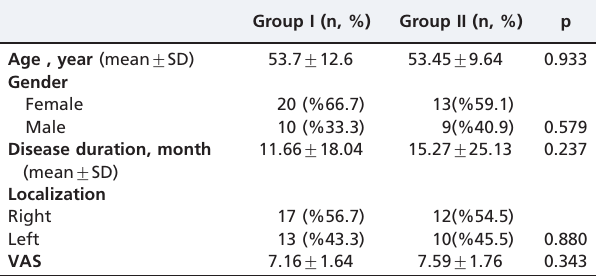
Table 1 - The sociodemographic and clinic characteristic of the patients.